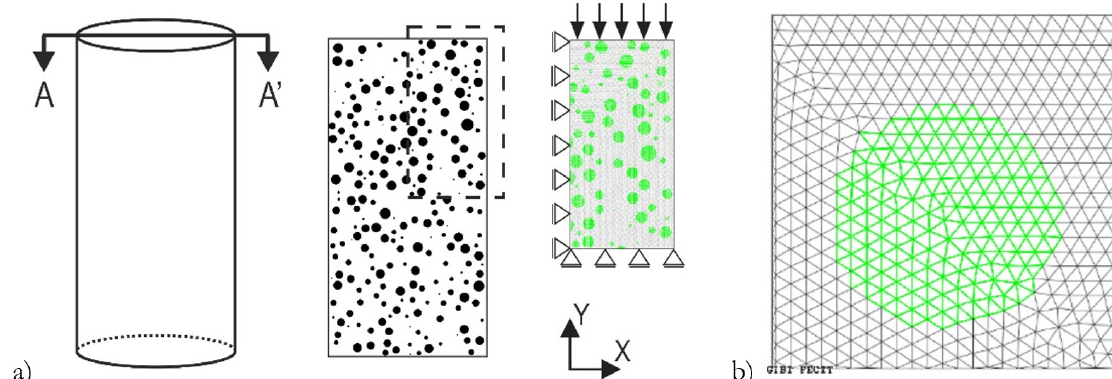
Figure 2 N umerical representation of one LWAC sample: (a) The geometry of the modeled LWAC sample (16-cm diameter and 32-cm height), from which a middle cross section was used; (b) Typical FE triangle mesh used; the round green circle representing the aggregate, surrounded by the mortar, in